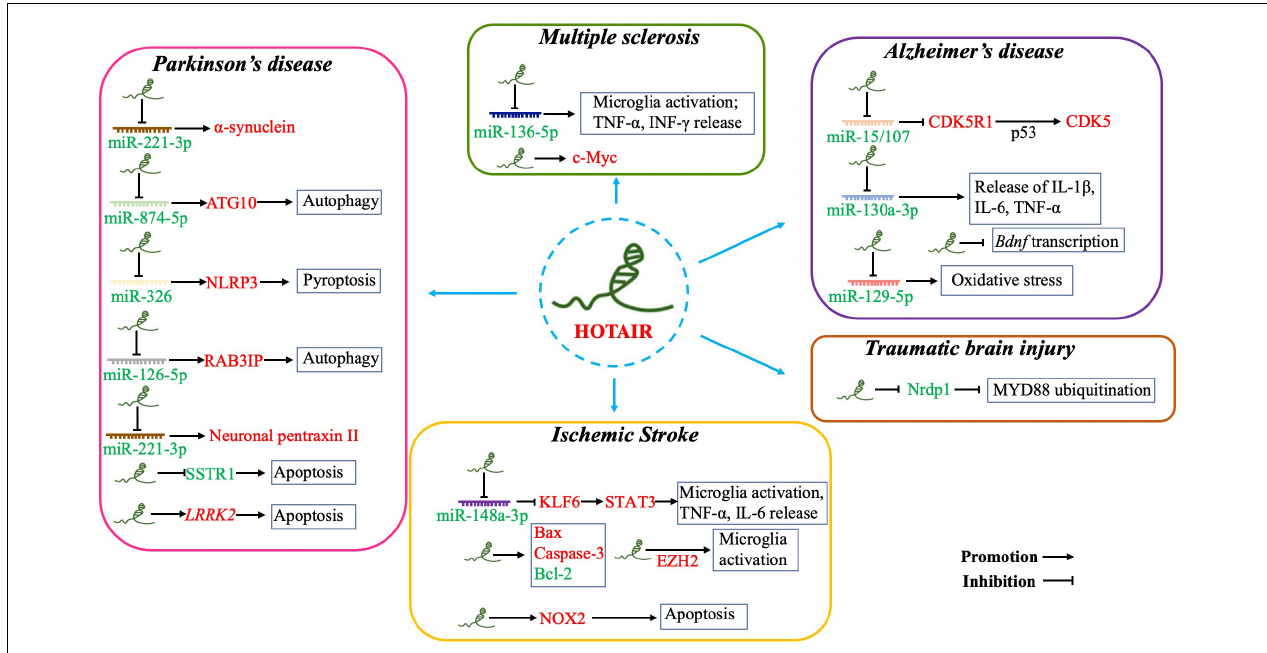
FIGURE 2 | Overexpressed HOTAIR is involved in the pathogenesis of CNS disorders by sponging miRNAs, inducing apoptosis, promoting microglia activation and neuroinflammation, enhancing oxidative stress, and inhibiting Bdnf transcription. (i) Parkinson’s disease: HOTAIR acts as competing endogenous RNA by sponging miR-211-3p, miR-874-5p, miR-326, and miR-126-5p. HOTAIR also induces apoptosis by inhibiting SSTR1 or promoting LRRK2 expression. (ii) Ischemic stroke: Overexpressed HOTAIR acts as competing endogenous RNA by sponging miR-148a-3p to upregulate STAT3; promoting microglia activation and the release of pro-inflammatory factors; and upregulating EZH2, also a pathway regulated by HOTAIR to activate microglia. HOTAIR promotes apoptosis by upregulating Bax, Caspase-3, and NOX2, as well as by downregulating Bcl-2 expression. (iii) Alzheimer’s disease: Overexpressed HOTAIR acts as competing endogenous RNA by sponging miR-15/107, miR-130a-3p, and miR-129-5p to promote apoptosis, oxidative stress, and neuroinflammation. HOTAIR is also involved in the pathogenesis of AD by inhibiting Bdnf transcription. (iv) Multiple sclerosis: Overexpressed HOTAIR sponges miR-136-5p to promote microglia activation, release of TNF- α and IFN- γ , and upregulate c-Myc expression. (v) Traumatic brain injury: Overexpressed HOTAIR inhibits MYD88 ubiquitination to repress microglial activation. Red and green fonts represent high and low expression,